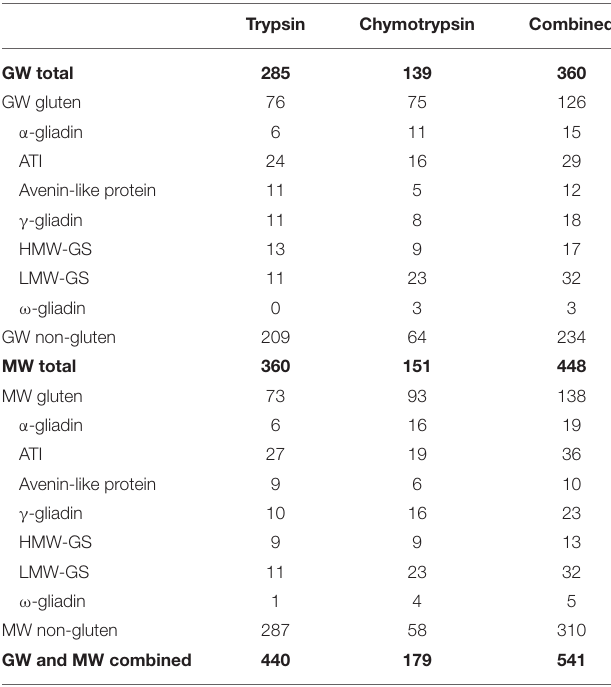
TABLE 1 | Numbers of distinct proteins and of gluten and ATI proteins identified at 99% confidence in trypsin and chymotrypsin